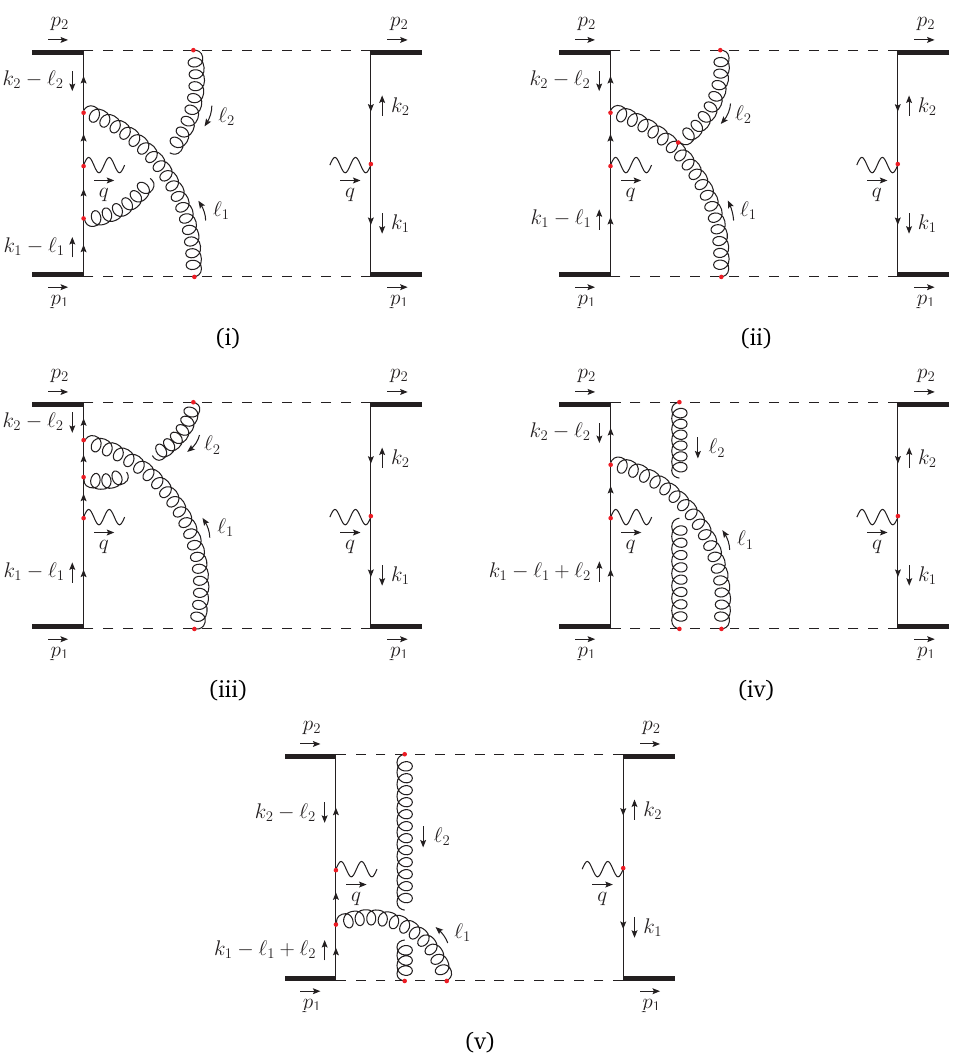
Figure 5: ‘Colour-entangled’ diagrams contributing to the dBM part of the DY cross section in ) . This set is supplemented by graphs that can be obtained by p ↔ ¯ p or the model at (cid:79) ( α 2 s Hermitian conjugation, and for diagrams (iv) and (v) there are also ‘seagull’ versions where the two gluon attachments on the lower scalar lines merge into one.